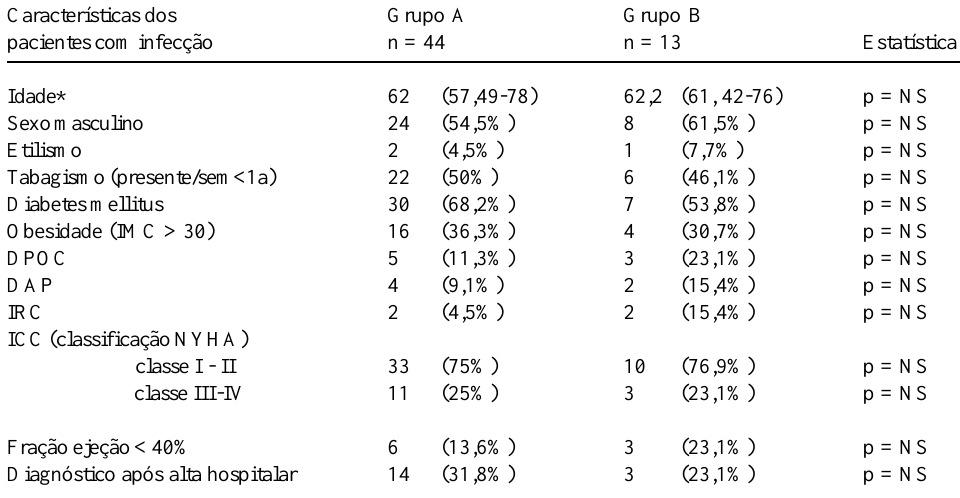
Tabela 3. Características dos pacientes com infecção em cada grupo. Características dos